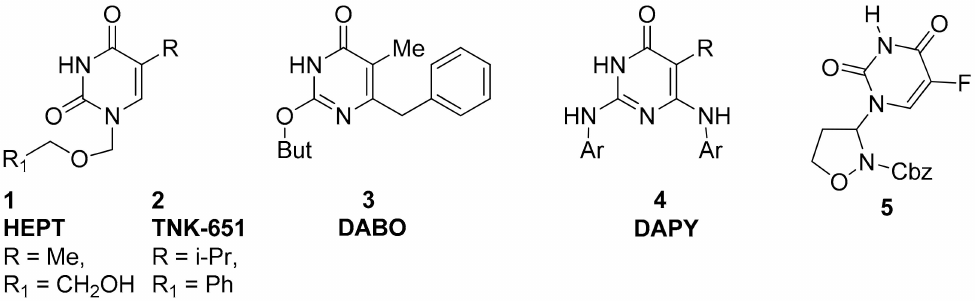
Figure 1. Modified pyrimidines as non-nucleoside reverse transcriptase inhibitors